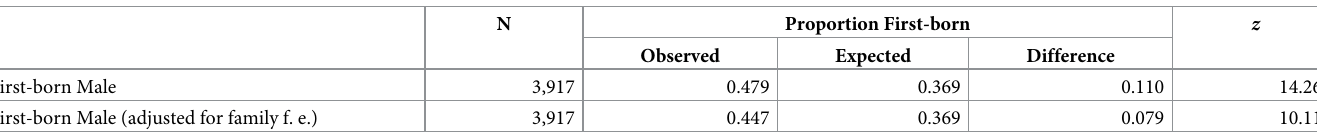
Table 8. Out of sample evidence using data from Black et al.